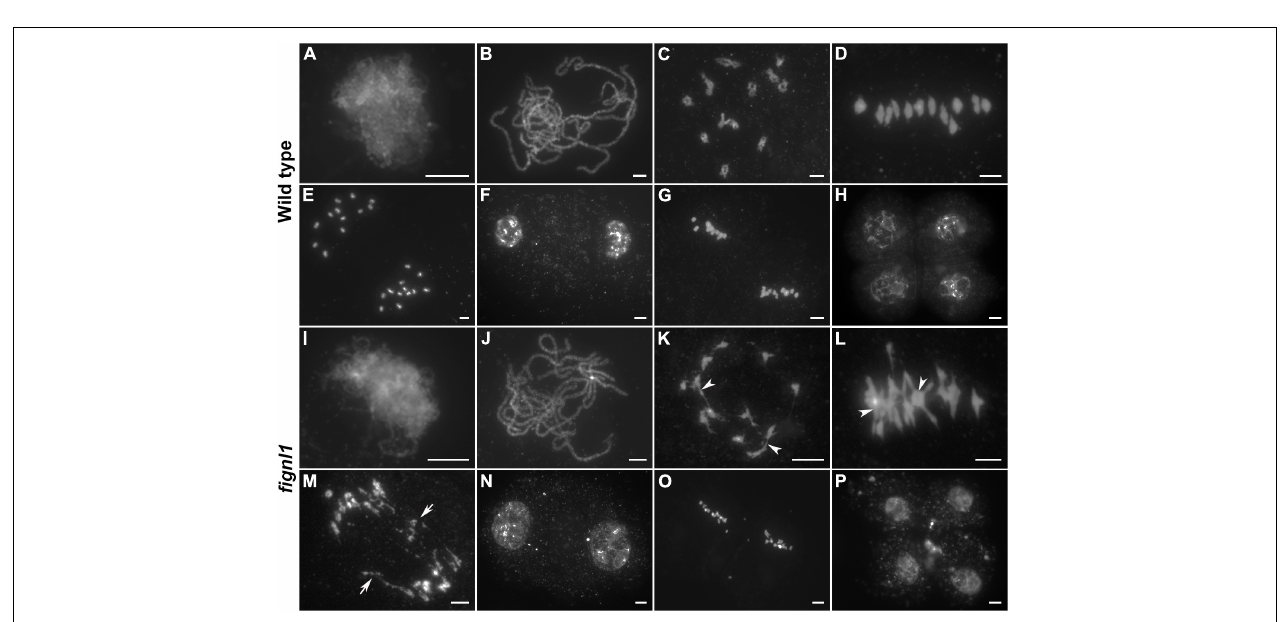
FIGURE 1 | Characterization of the fignl1 mutant and structure of the FIGNL1 protein. (A) Comparison of wild-type and fignl1 plants. (B) Viable pollen grains of wild type. Bar, 50 µ m. (C) Inviable pollen grains of the fignl1 mutant. Bar, 50 µ m. (D) Gene structure and mutation of FIGNL1 . Coding regions are shown as black boxes. Untranslated regions are shown as black lines. Deleted region in the fignl1 mutant is shown as a dotted box. (E) Protein structure of FIGNL1. (F) Multiple sequence alignment of the ATPase region. Os, Oryza sativa ; At, Arabidopsis thaliana ; Ce, Caenorhabditis elegans ; Mm, Mus musculus .